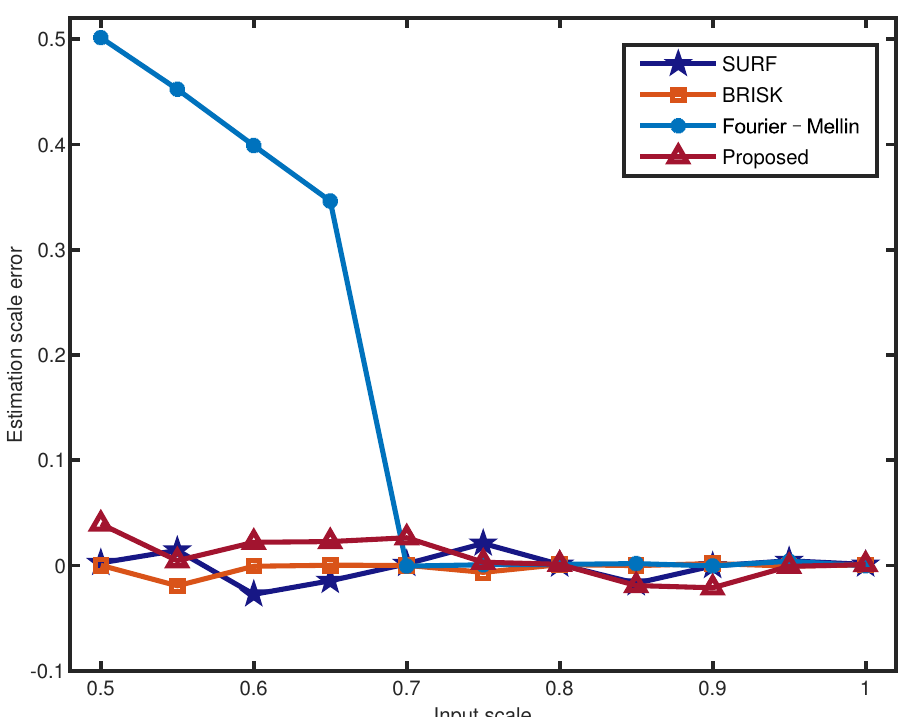
Figure 9. Scale estimation errors for different input scales of the Lena image with σ = 25.